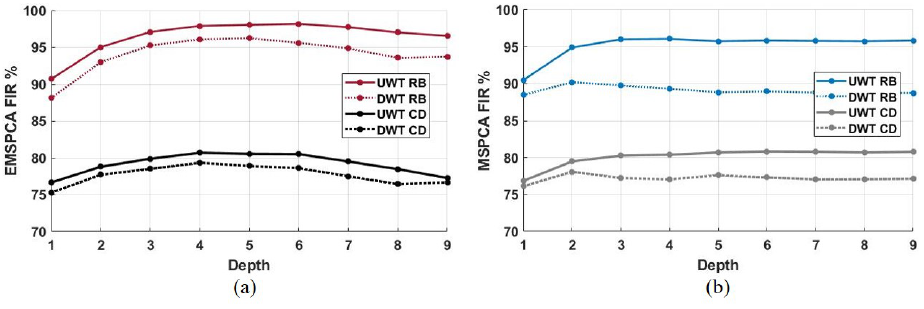
Figure 13. Decimated (DWT) and undecimated (UWT) comparison of RB and CD FIR across all depths and a fixed fault size of 1 sigma; ( a ) results with EMSPCA, ( b ) results with